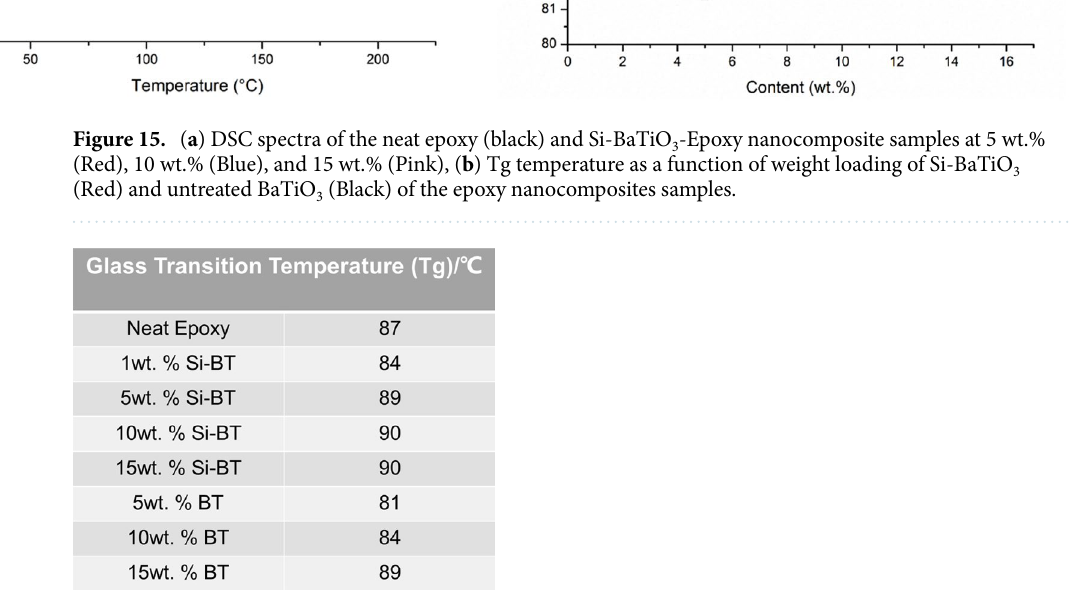
Figure 16. Glass transition temperatures of silane treated and untreated BaTiO 3 -Epoxy